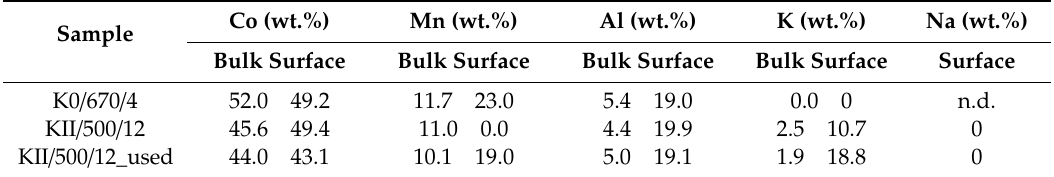
Table 5. Comparison of bulk (from inductive coupled plasma (ICP)) and surface (from XPS) catalysts composition in wt.%.